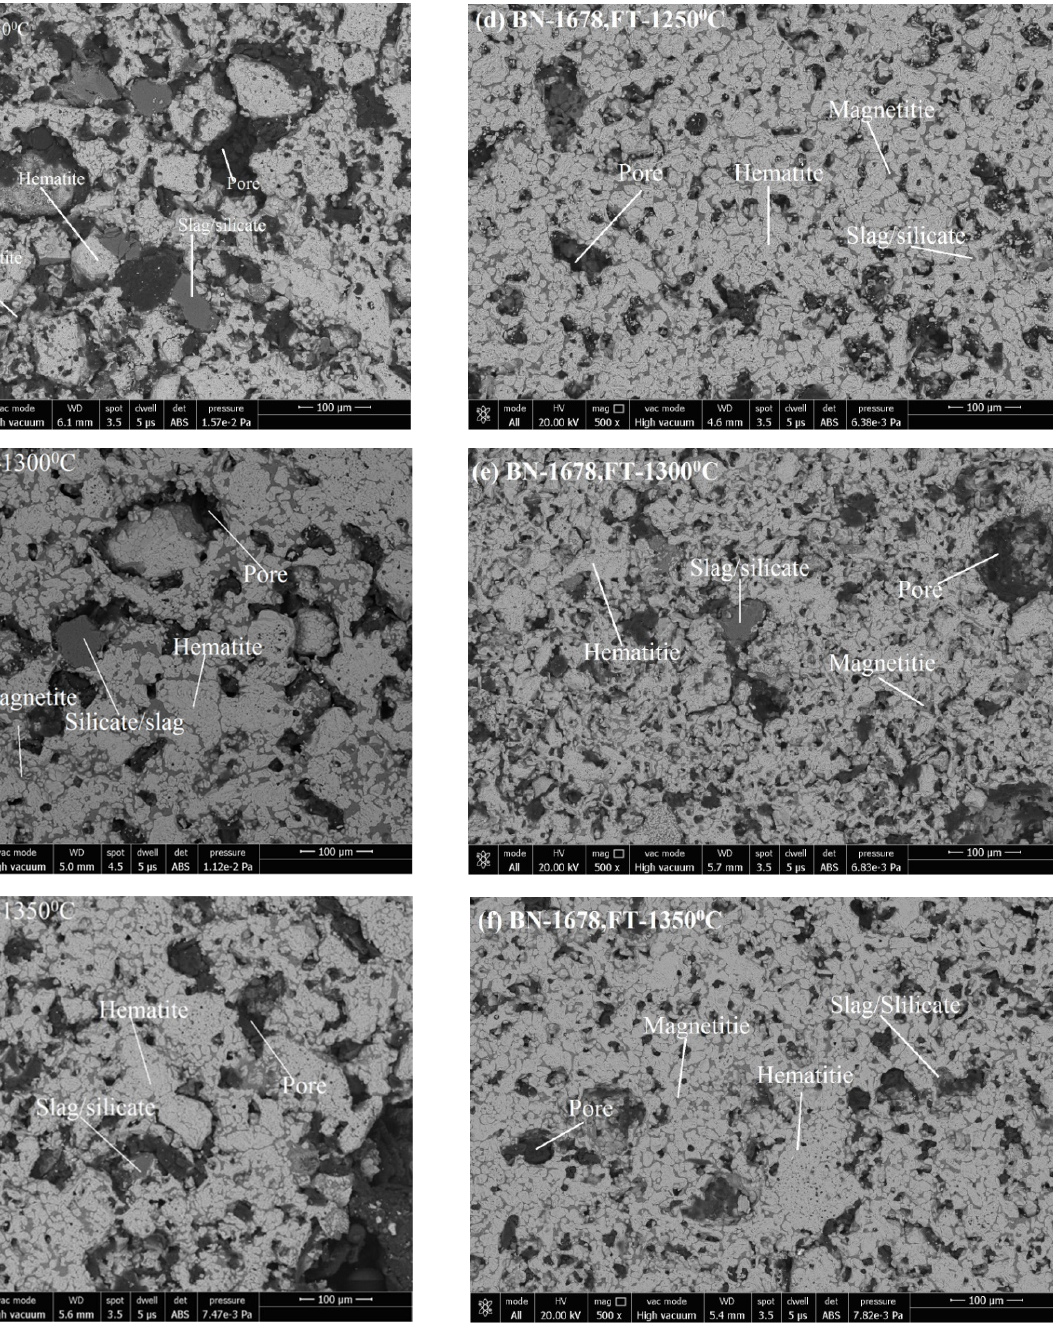
Figure 4. Effect of (Mesh no.) fineness on A.P. of iron ore No.1/No.2 pellets.